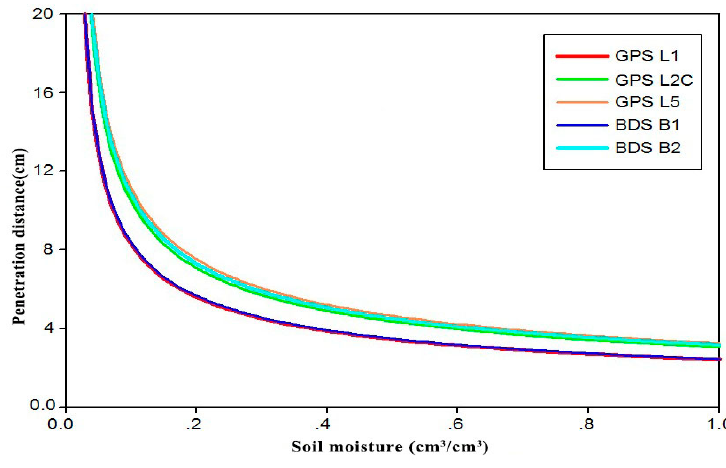
Figure 7. Dependence of the penetration distance on soil moisture for different frequency bands.